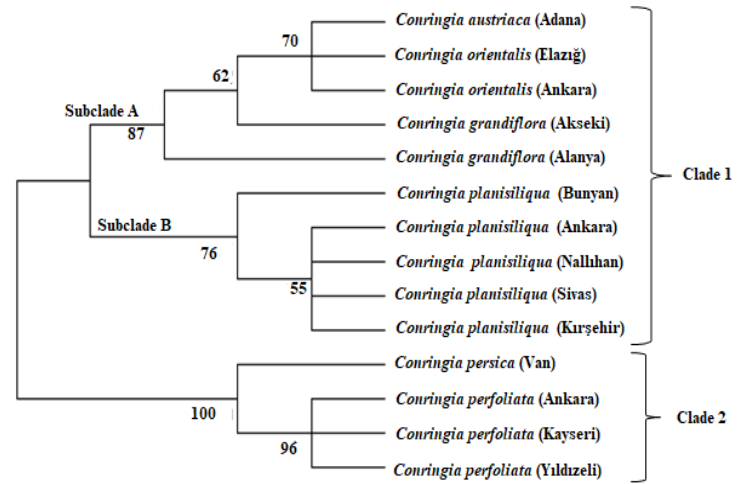
Figure 2. The Neighbour joining tree generated using cpDNA trn L-F sequences Conringia genus (Bootstrap values greater than 50% are given above